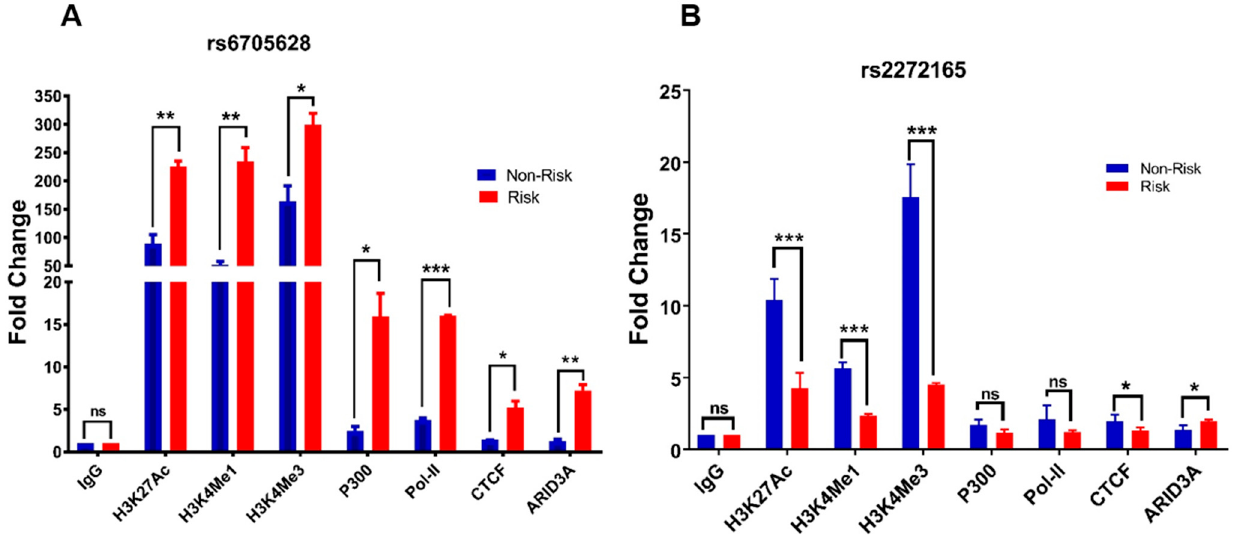
Figure 5. Allele-specific ChIP-qPCR of sequences containing SNPs ( A ) rs6705628 and ( B ) rs2272165 with histone marks and binding proteins ( x- axis) using risk (GM18572) and non-risk (GM18553) LCL lines. p -values are for Student’s t -test. * p < 0.05, ** p < 0.01, *** p < 0.001.